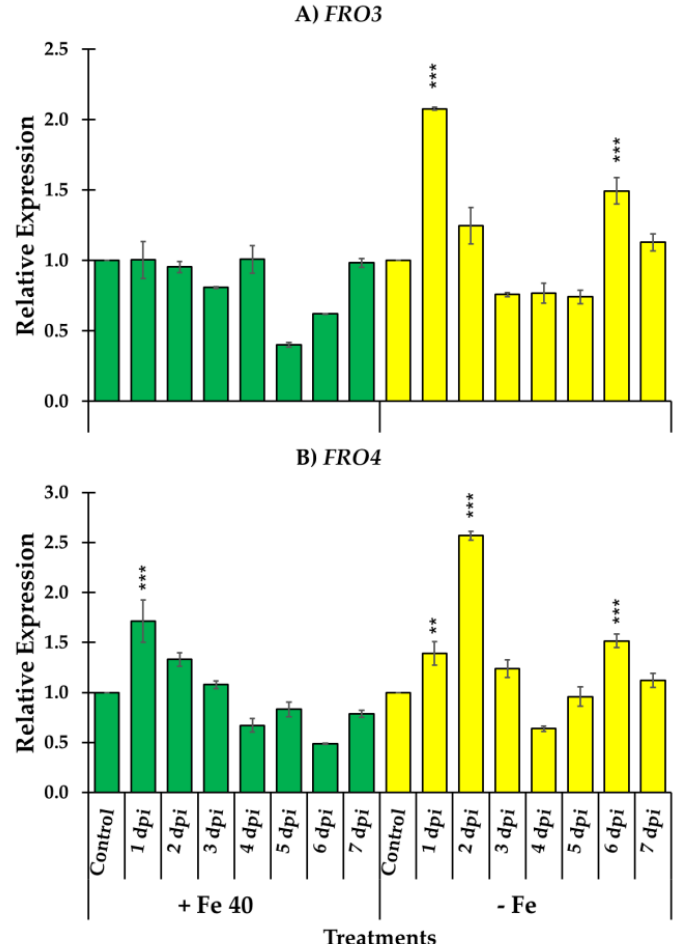
Figure 5. Relative expression of FRO3 ( A ) and FRO4 ( B ) on shoots of C. melo . Four treatments were used, namely, (i) Control + Fe40 µ M (un-inoculated), (ii) Inoculated + Fe40 µ M, (iii) Control - Fe (un-inoculated) and (iv) Inoculated - Fe. The expression of control treatment for each nutritional condition is presented once, at the beginning of the graph, with the relative expression comparison method used, the control is always equal to 1. Data of gene expression represent the mean of three independent technical replicates, according to the Dunnett’s test, * ( p < 0.05), ** ( p < 0.01) or *** ( p < 0.001) over the bars indicate significant differences in relation to the control treatment.